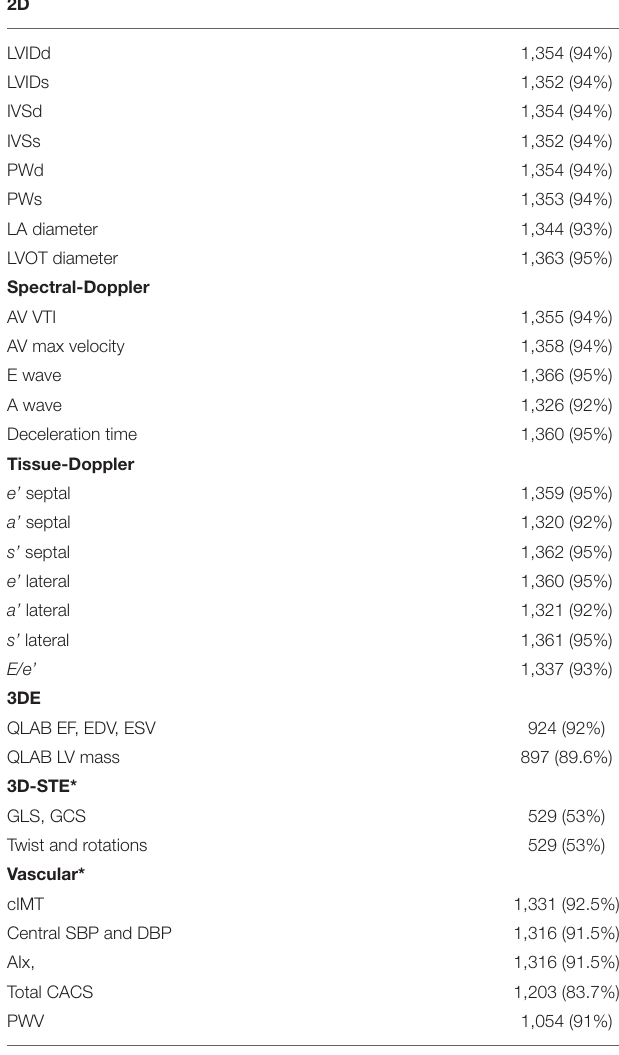
TABLE 4 | Feasibility of the cardiovascular measures in 1,438 SABRE